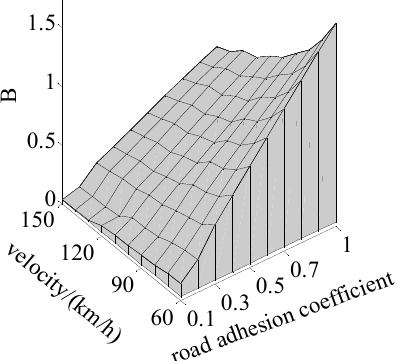
Figure 4. The map for the boundary-line intercepts.